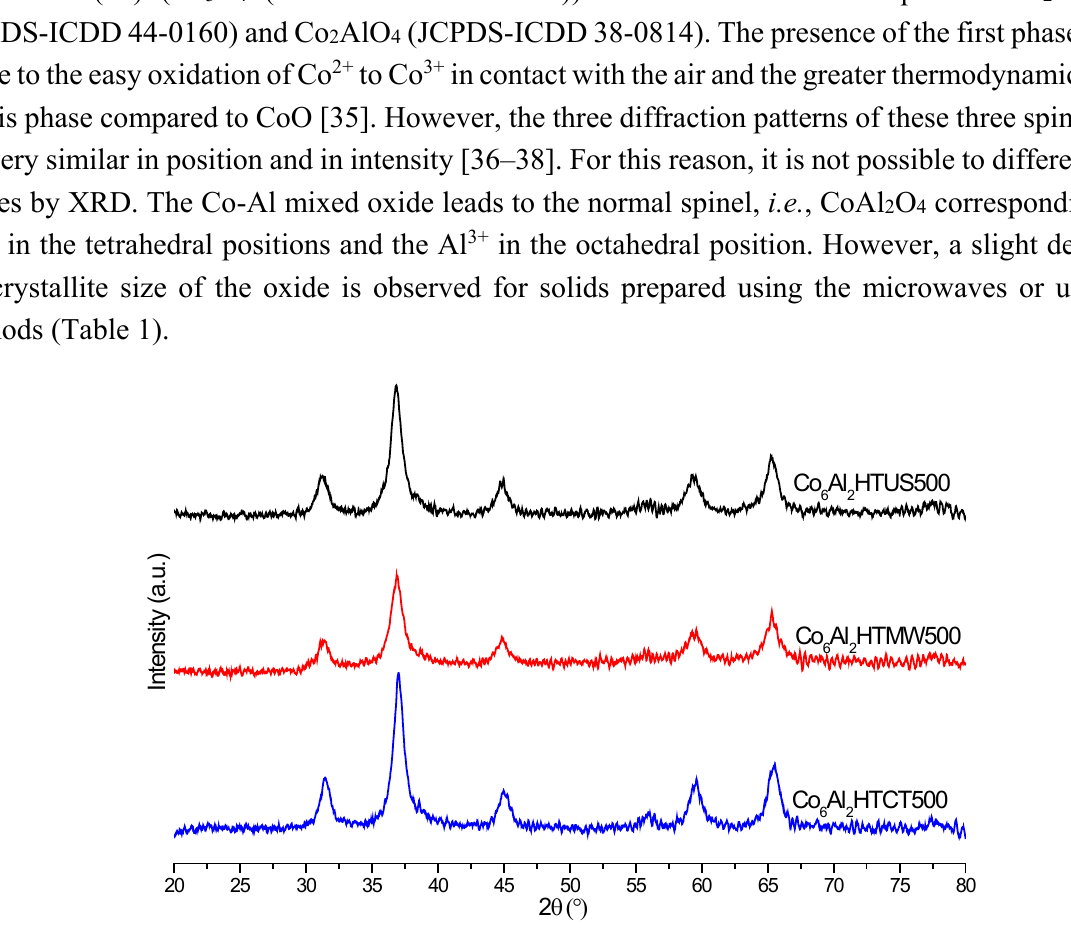
Figure 2. X-ray diffraction patterns of the mixed